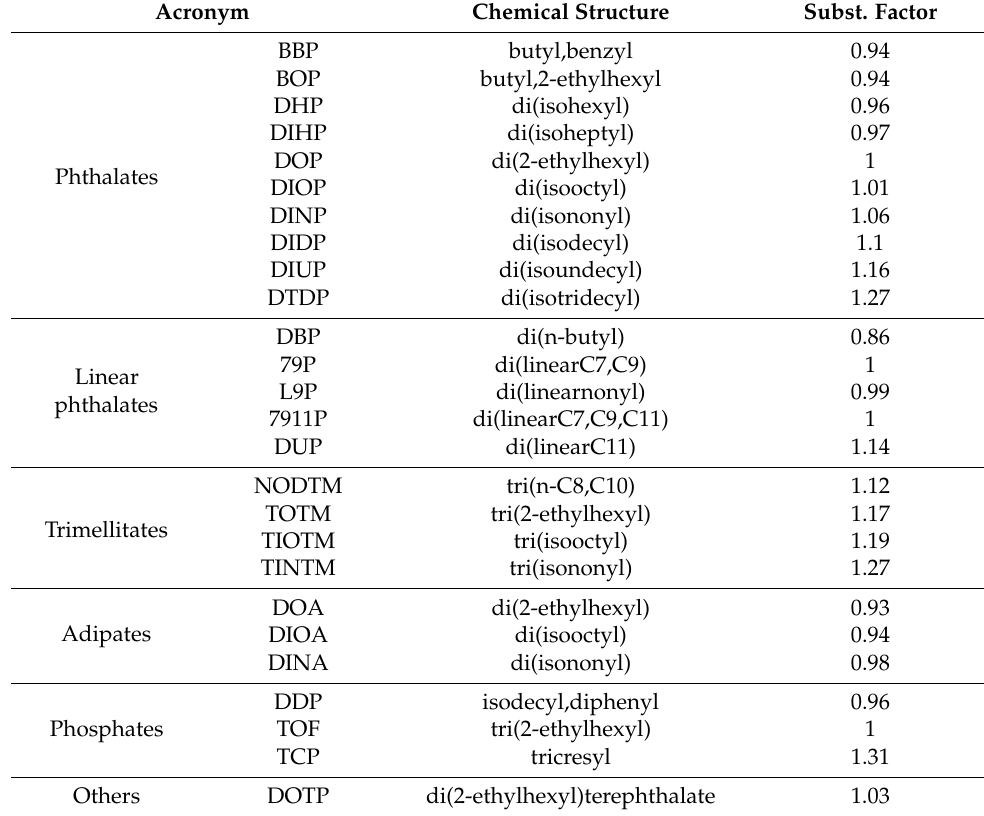
Table 1. Plasticizer Acronyms, Chemical Compositions, and Substitution